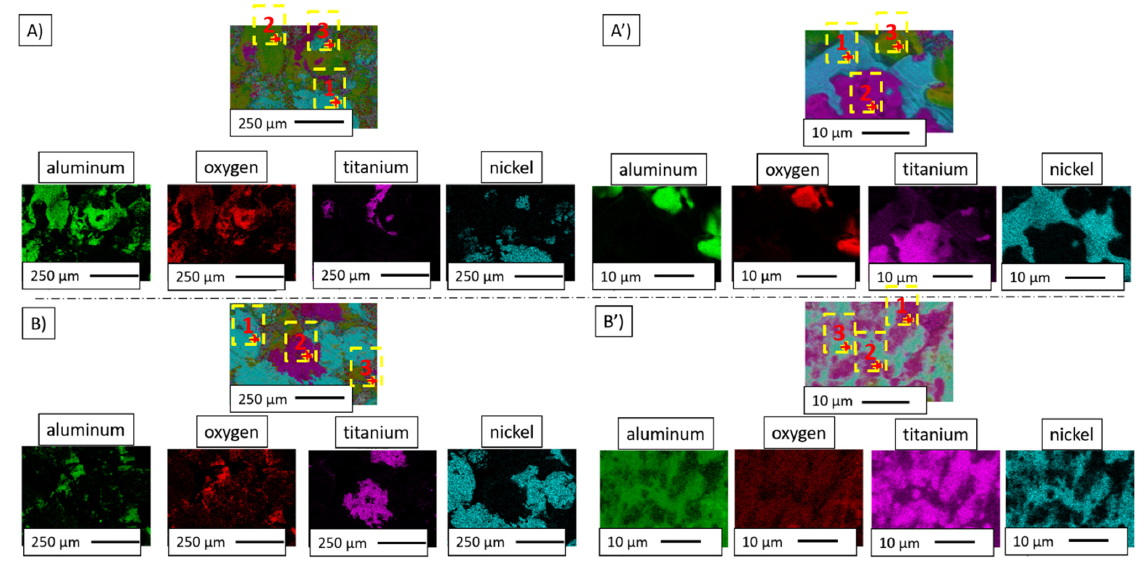
Figure 12. Chemical element distribution maps for samples: ( A , A’ ) Series I; ( B , B’ ) Series II. Table 4. Chemical composition of characteristic areas of the composites. Measurement areas are shown in Figure 12. Chemical Composition Series Image Point O Al Ti Ni %wt. %at. %wt. %at. I